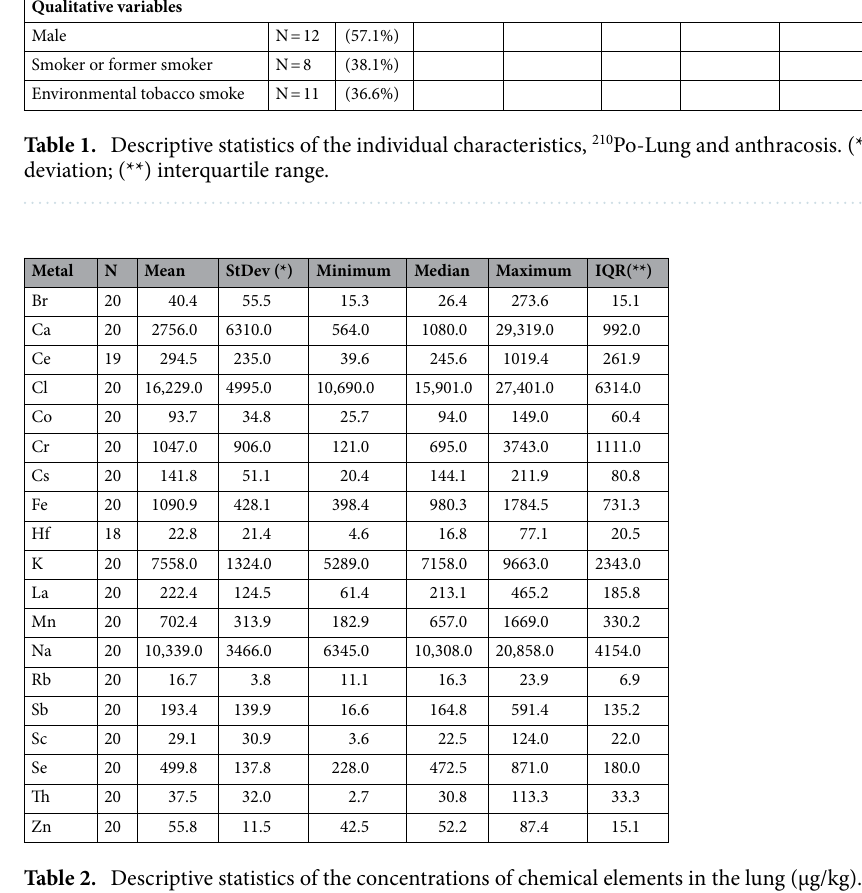
Table 2. Descriptive statistics of the concentrations of chemical elements in the lung (µg/kg). (*) standard deviation; (**) interquartile range.